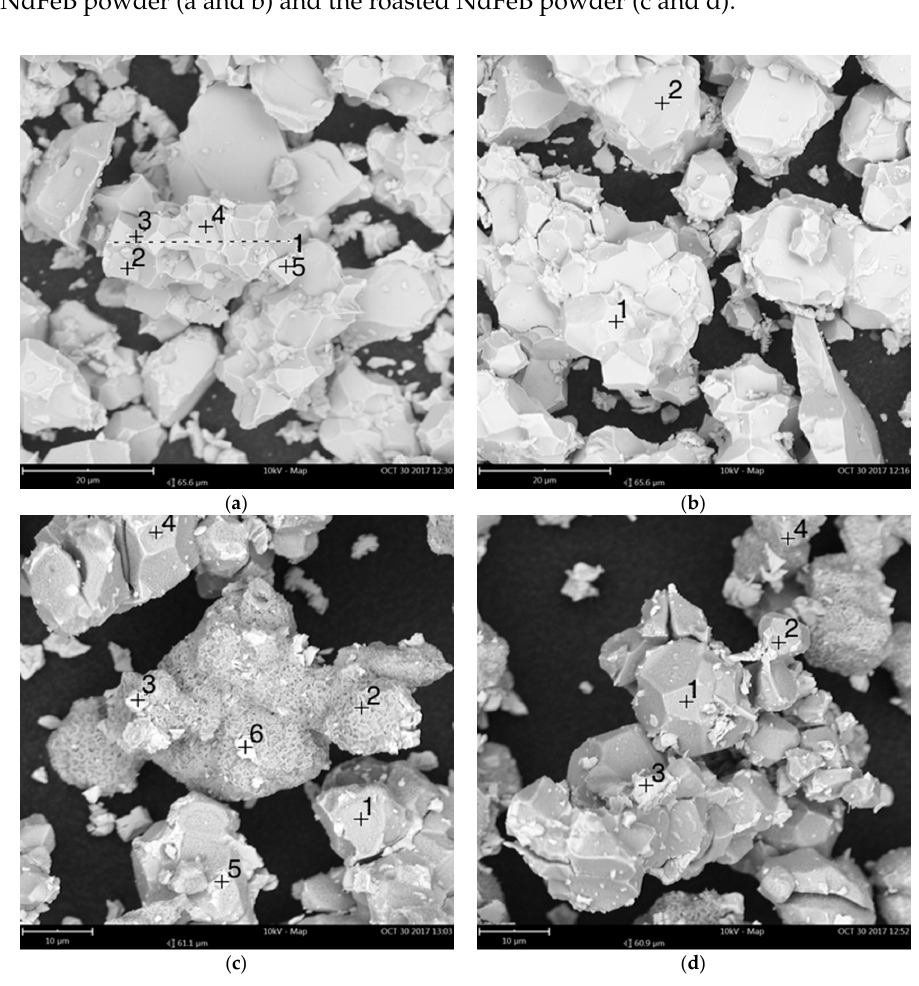
Figure 1. Four different SEM magnifications (4100×, 10 kV‐Map) HD NdFeB powder in two different locations ( a , b ) and roasted neodymium magnet powder sample in two locations ( c , d ). The crosses and lines on the SEM pictures show the locations where the EDX analysis was performed. In Figure 1a,b, it can be observed that the morphology of the powder looked even except for the